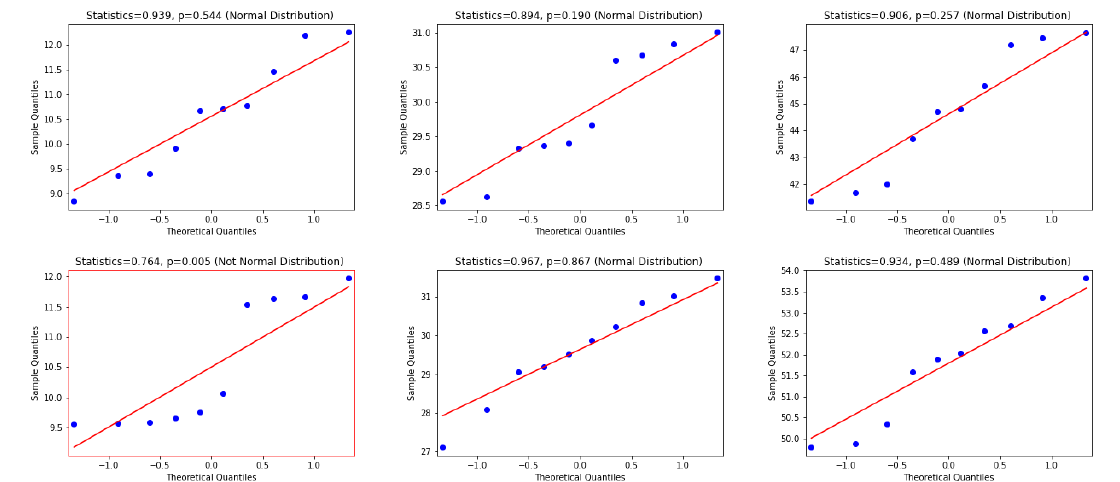
Figure 7. This figure provides Quantile–quantile plots with the p -values of the Shapiro–Wilk test for the differences between CER, WER, and SER results in Section 5.2 represents the distributions of Bluche that are computed in terms of test1 and test2